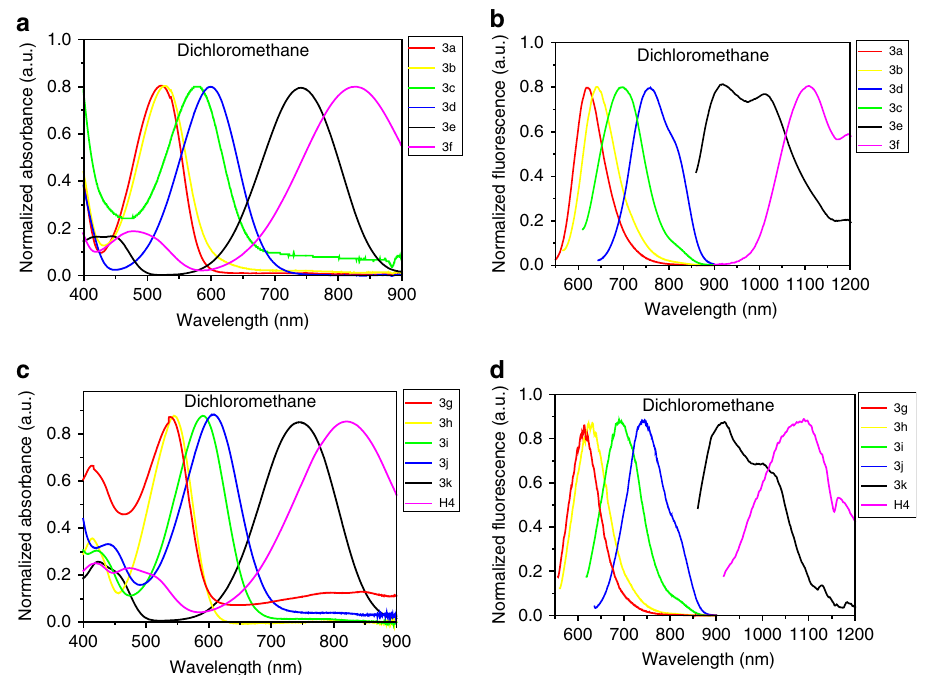
Fig. 3 Spectroscopic properties of 3a – 3k and H4. a Absorption wavelength and b emission wavelength of 3a – 3f in dichloromethane. c Absorption wavelength and d emission wavelength of 3g – 3k and H4 in spacer in compounds 3f and H4, and using N,N -dimethylaniline as an electron donor to strengthen the intramolecular charge- transfer (ICT) effect. Moreover, 3f and H4 presented higher-lying